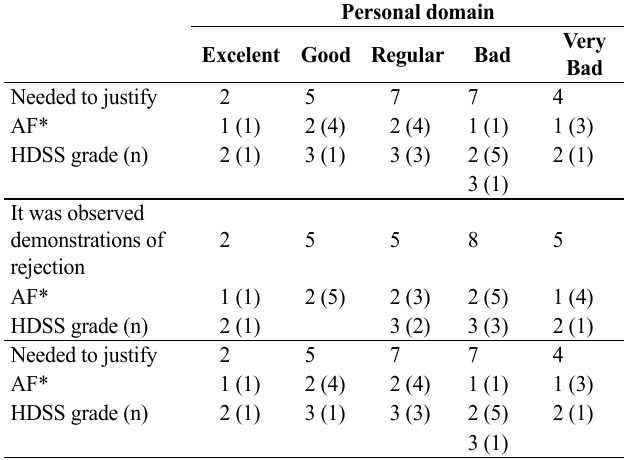
Table 6: Distribution of the emotional domain of the 25 Physical Ed- ucation students with primary hyperhidrosis from a private university in Aracaju-SE, from August to November 2017, according to the clas- sification of the quality of life questionnaire